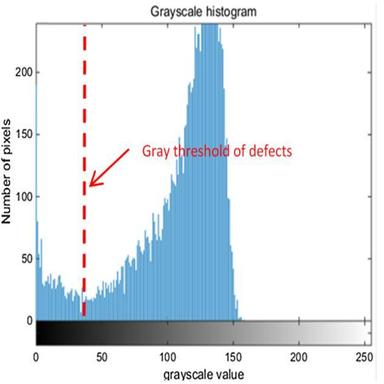
Gray histogram of μ-CT images.